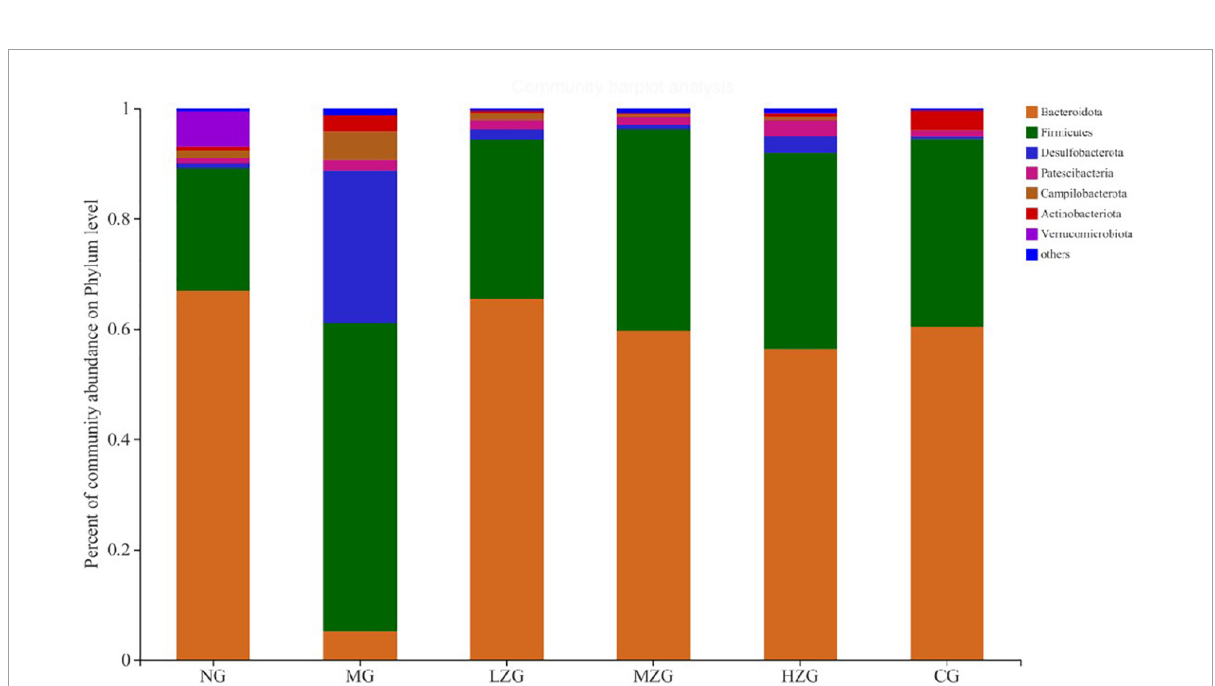
FIGURE5 Gut microbial composition of different samples at the phylum level. The abscissa is the sample name, the ordinate is the proportion of the species in the sample, the columns with different colors represent different species, and the length of the columns represents the proportion of the